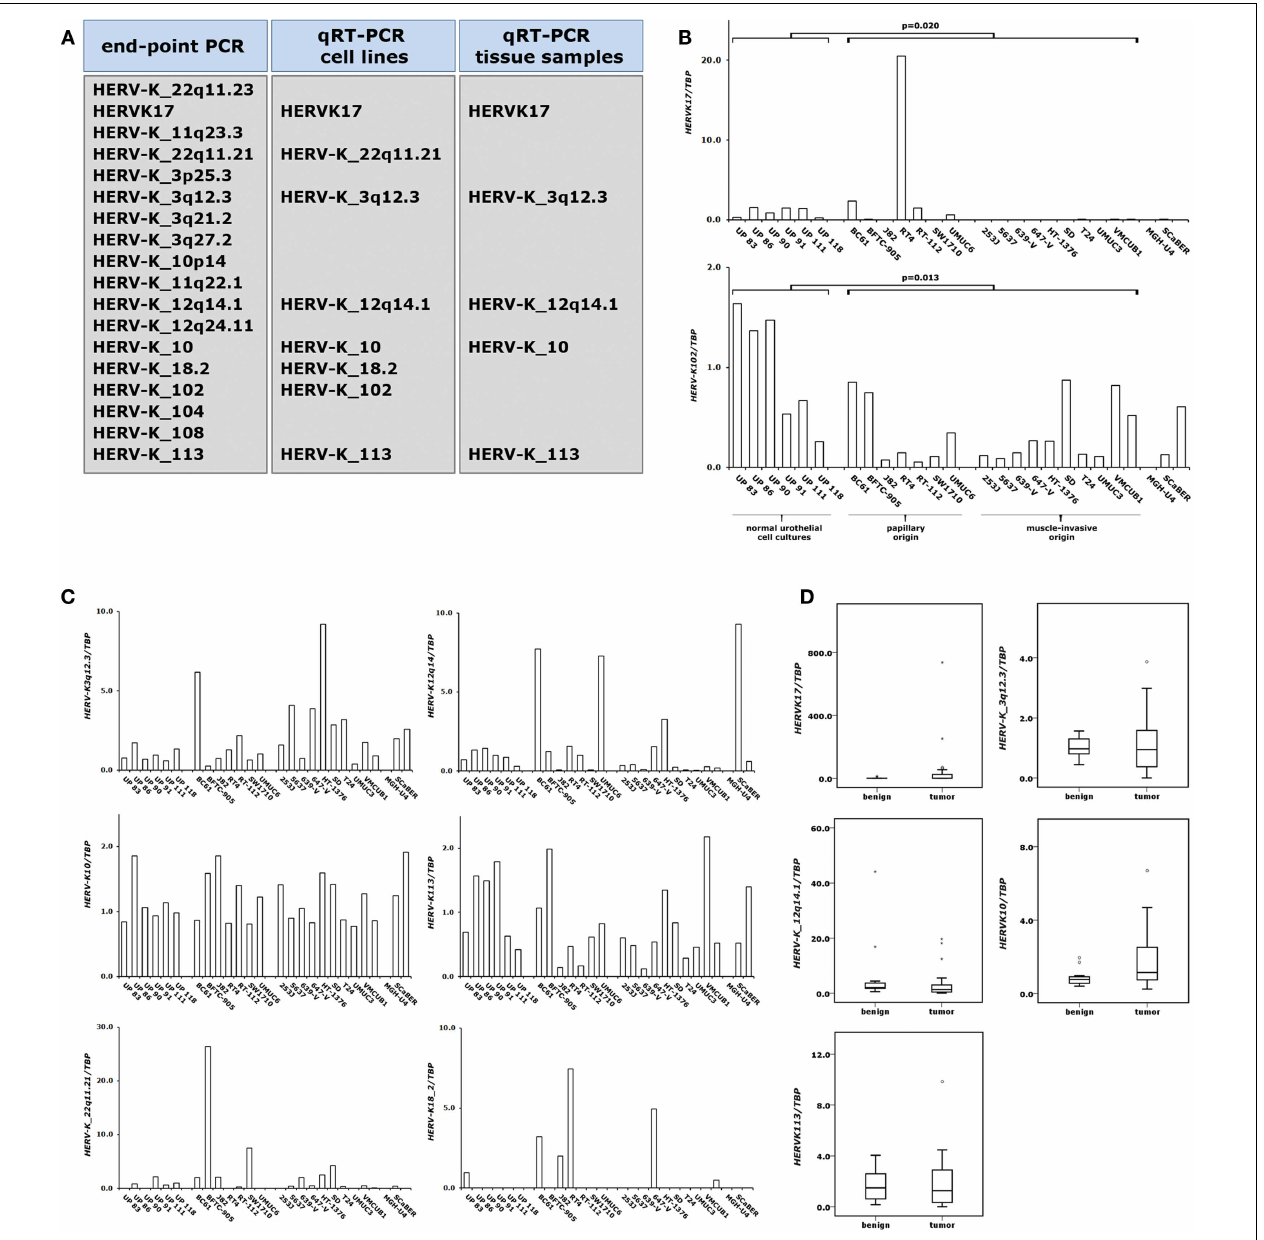
FIGURE 4 | Expression changes of proviral HERV-K elements in bladder cancer . Expression of different HERV-K elements was assessed by end-point PCR and qRT-PCR as indicated in (A) . HERV-K RNA levels were measured by qRT-PCR in 6 normal urothelial cell cultures and 18 bladder cancer cell lines